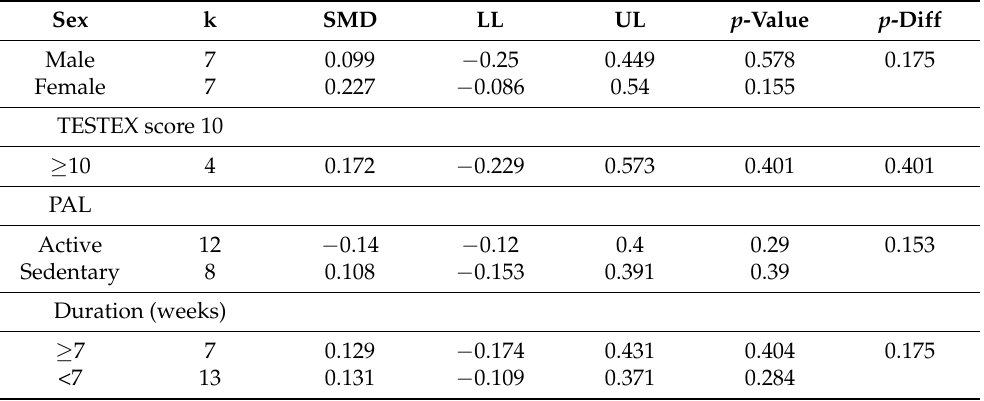
Table 3. Subgroup